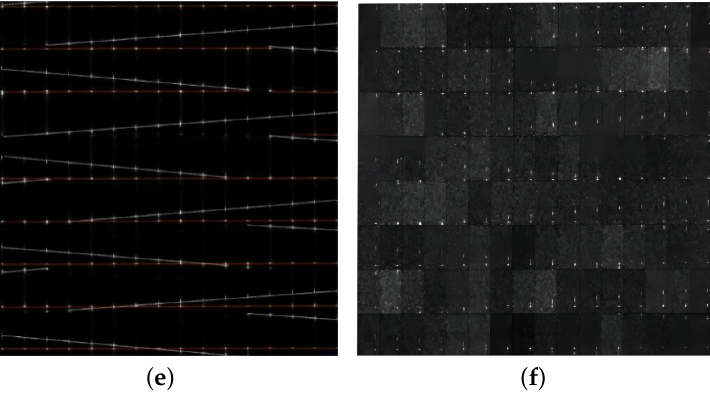
Figure 5. Feature analysis of the signals overlapping in the frequency domain. ( a ) FSST (20 dB); ( b ) FSST ( − 15 dB); ( c ) SPWVD (20 dB); ( d ) SPWVD ( − 15 dB); ( e ) DR2D (20 dB); ( f ) DR2D ( − 15 dB).